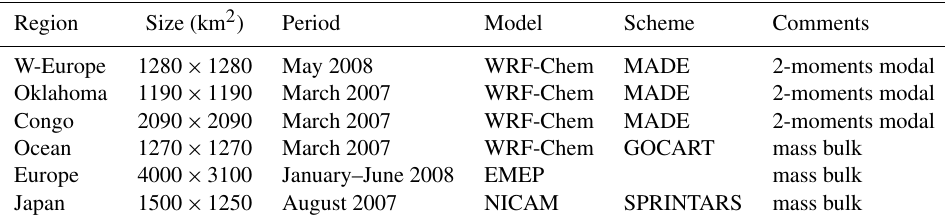
Table 1. Simulations analysed in this study.